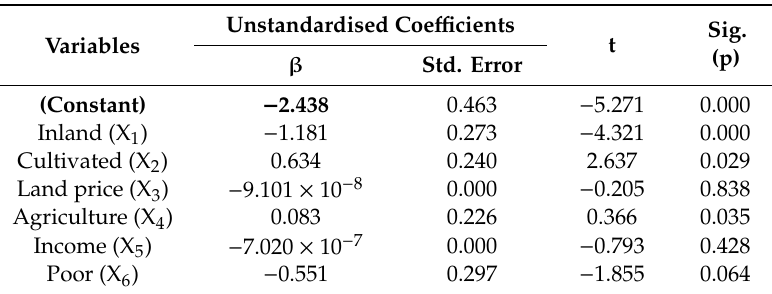
Table 7. Coe ffi cients of